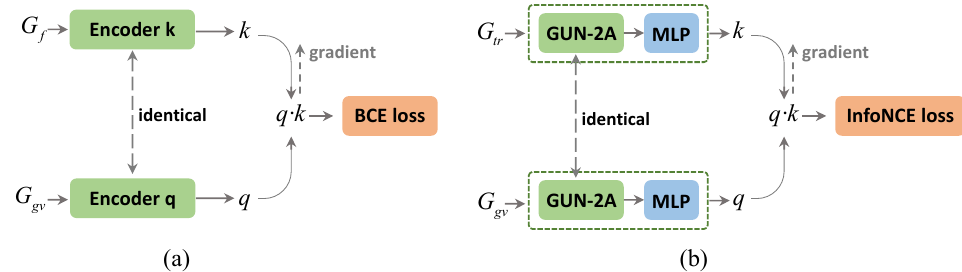
Figure 5. A paradigm comparison of the contrastive learning module in DKG ( a ) and CGUN-2A ( b ) with different inputs, graph encoders and loss function.